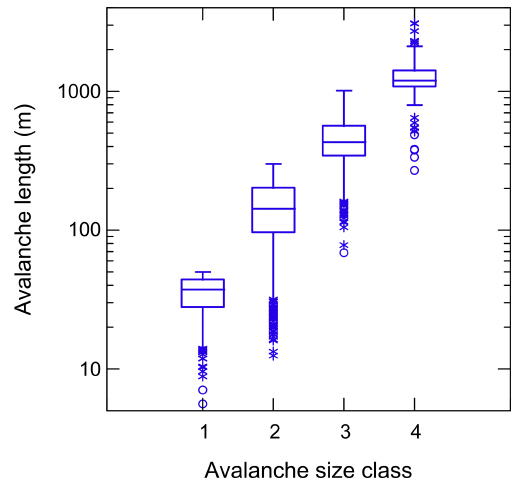
Figure 1. Distribution of avalanche length per avalanche size class for the 21-year data set of avalanche observations from the region of Davos applying the classification criteria given in Table 1. Boxes span the interquartile range from the first to third quartiles with a horizontal line showing the median. Whiskers show the range of ob- served values that fall within 1.5 times the interquartile range above the third and below the first quartiles. Asterisks and open circles re- fer to outliers and far outliers beyond the fences. Numbers indicate avalanches per class; total number of avalanches: N =